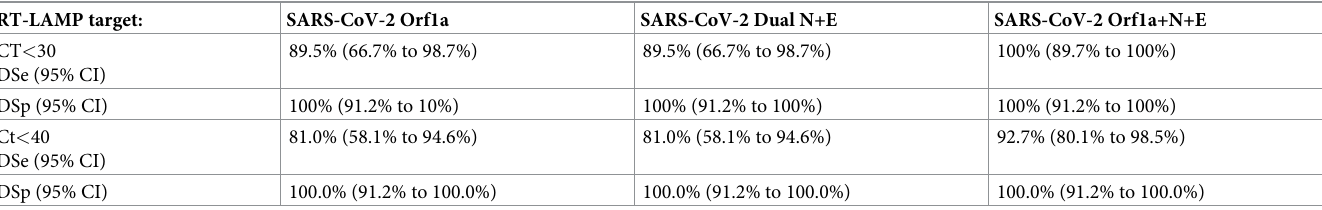
Table 4. DSe and DSp of single genomic, dual sub-genomic and triple genomic / sub-genomic SARS-CoV-2 colorimetric end-point RT-LAMP assays. RT-LAMP